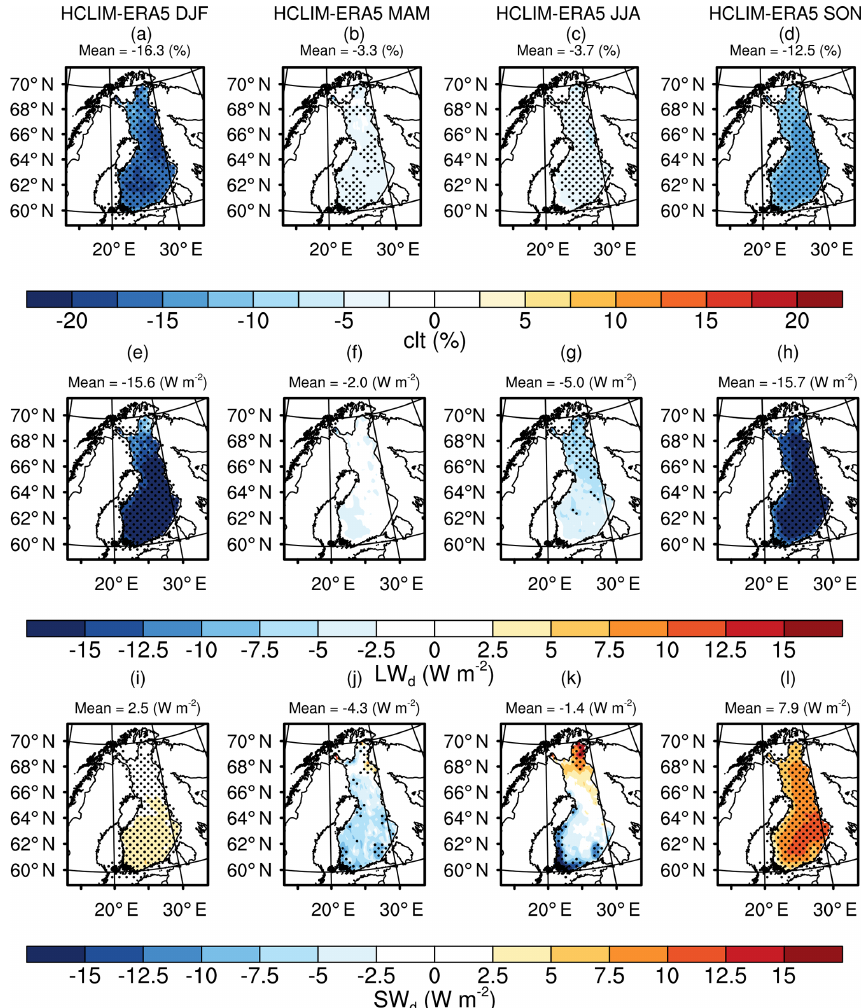
Figure 8. The biases in the simulated seasonal means of (a–d) total cloud fraction (clt), (e–h) downwelling longwave and (i–l) shortwave radiation (LW d and SW d , respectively) with a reference to the ERA5 reanalysis product. The seasonal mean biases were calculated over Finland for the time period of January 2002–December 2014. Stippled areas represent statistically significant differences with p values < 0 .